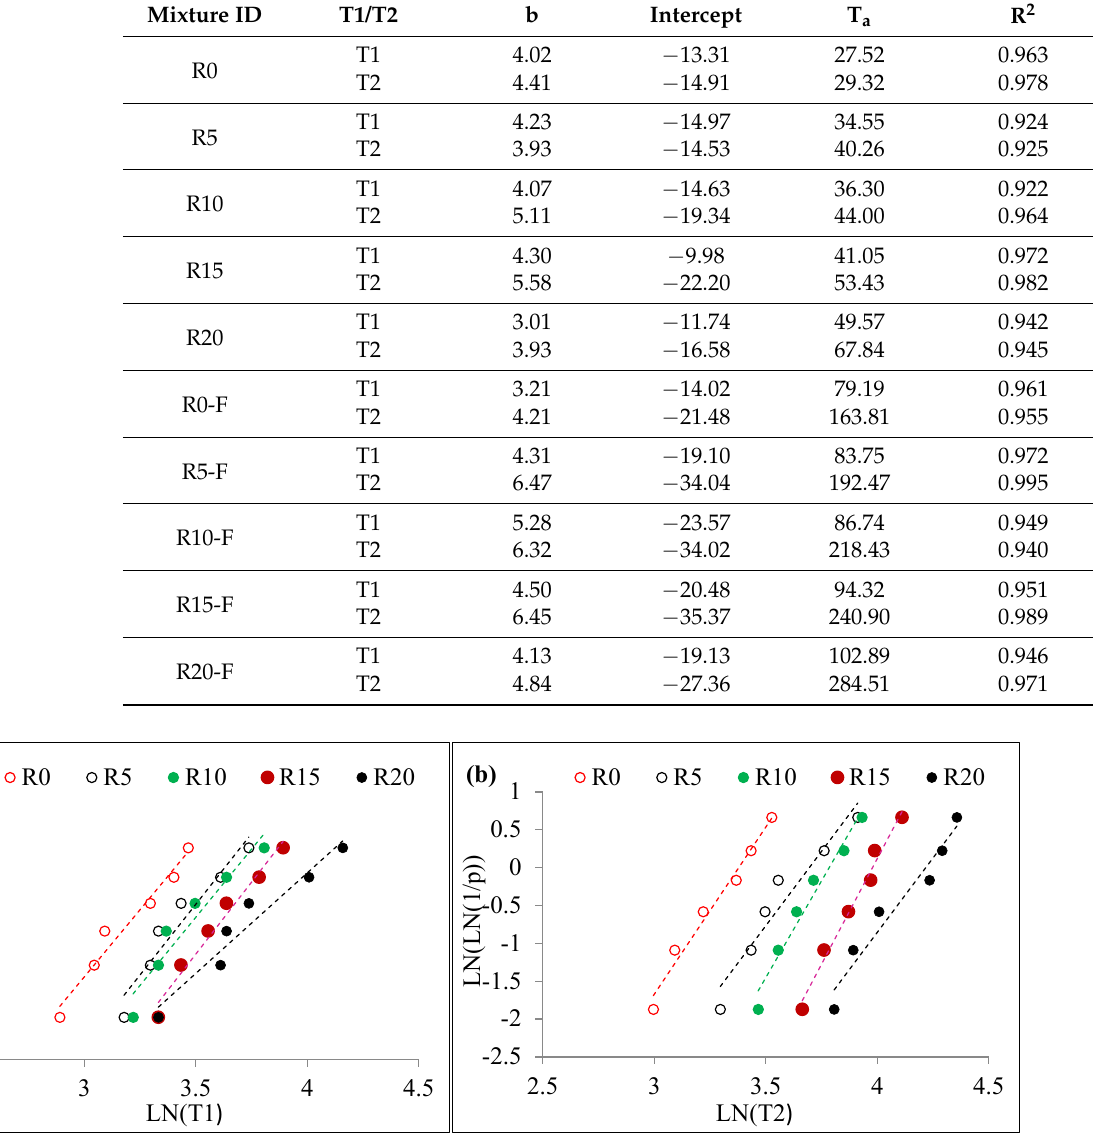
Figure 12. Weibull lines for Fibrous specimens ( a ) T1 and ( b ) T2. Table 4. Weibull parameters. Mixture ID